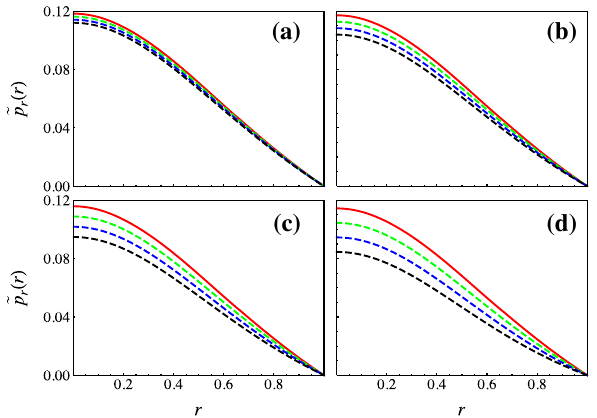
Fig. 4 Anisotropy Δ = ˜ p t − ˜ p r for M = 0 . 2, R = 1, c 1 = 0 . 5 and a C = − 0 . 1, b C = − 0 . 2, c C = − 0 . 3, d C = − 0 . 4. α = 0 . 1 (red line), α = 0 . 3, (green line), α = 0 . 5 (blue line), α = 0 . 7 (black line)